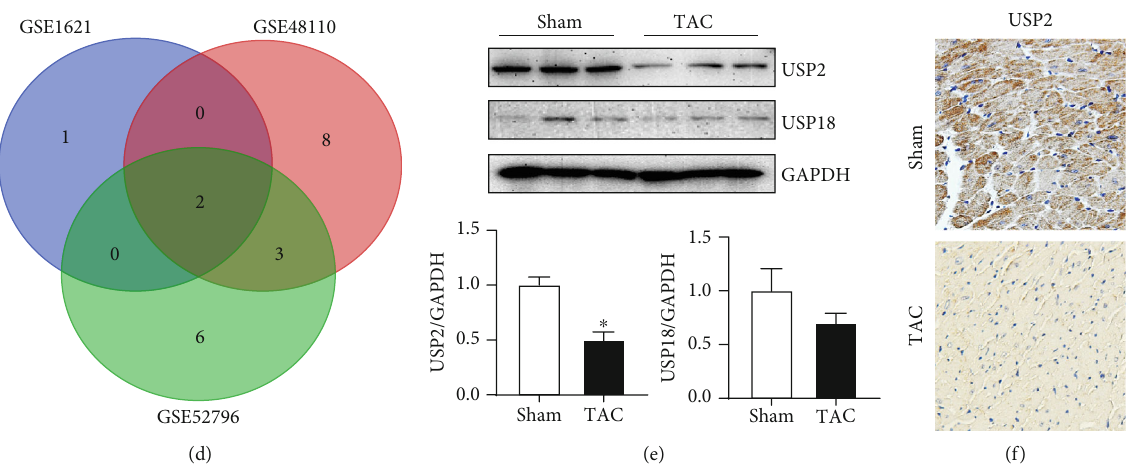
Figure 1: Cardiac USP2 is signi fi cantly decreased in response to pressure overload. (a – c) Hierarchical clustering and heat map analysis of TAC-related di ff erentially expressed genes in ubiquitin-speci fi c proteases family; (d) Venn diagrams of DGGs; (e) representative Western blot analyses of USP2 and USP18 in the heart tissues. Quanti fi cation of the relative protein levels. (f) Representative images of IHC staining of USP2 in the heart sections. ∗ P < 0 : 05 , n = 3